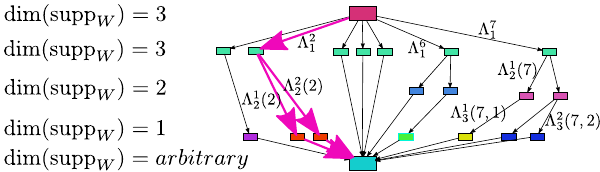
FIG. 3. The figure shows a diagram for a possible protocol defining a LOP map as described in Proposition 3. In this example, the input state is three-dimensional on the wire. All the arrows starting from the same node represent a CPTP map. Each arrow represents a submap with a given outcome (labeled from 1 on the left to n on the right). The dimension of the maximal support of the input or output states on the wire is stated on the left of the diagram. The branches can be grouped into four different types, where the types differ by how the dimension of the maximal support of the state on the wire [given without loss of generality by r ð ⃗ α t − 1 Þ , after applying t maps with the outcomes ⃗ α t ] changes during the protocol. Any possible branch type is depicted at least once. In this picture, the respective groups of outcomes for the four branch types are (we only name the outcome vectors